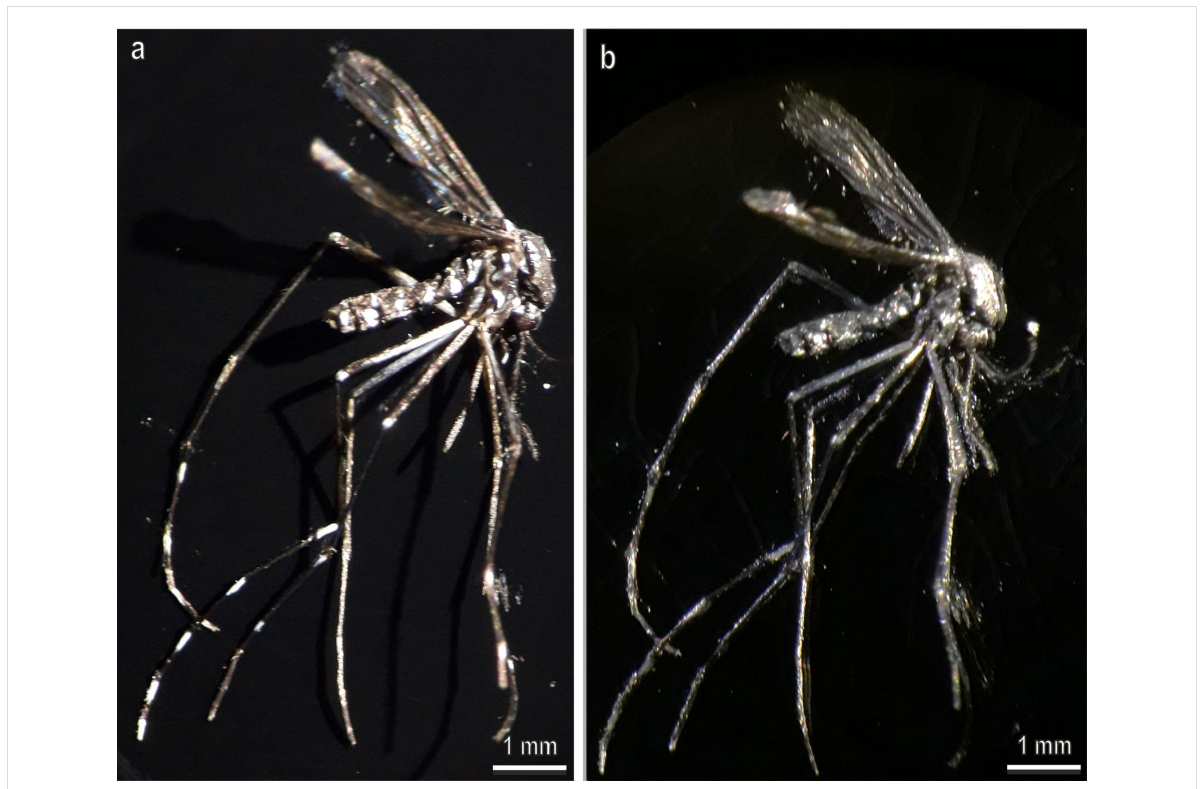
Figure 7: Aedes albopictus before (a) and after (b) Au/Pd sputter coating (10 nm film thickness). Note that in (b) the thin Au/Pd film screens the pig- ment inside the scales and eliminates the visual difference between white and black scales originally visible in the intact animal (a).